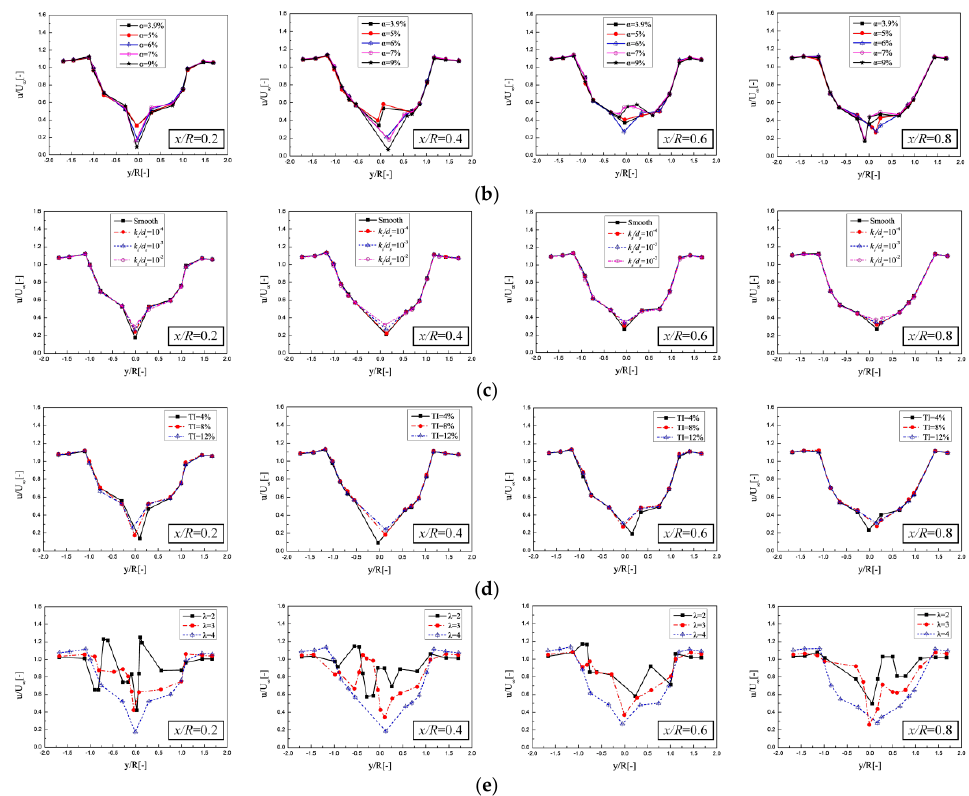
Figure 13. ( a ) The four measured positions of wind velocity inside the wind turbine; ( b ) fluctuation of wind velocity in downstream region of x / R = 0.2, 0.4, 0.6, 0.8 at different α ; ( c ) fluctuation of wind velocity in downstream region of x / R = 0.2, 0.4, 0.6, 0.8 at different k s / d s ; ( d ) fluctuation of wind velocity in downstream region of x / R = 0.2, 0.4, 0.6, 0.8 at different turbulence intensity (TI); and, ( e ) fluctuation of wind velocity in downstream region of x / R = 0.2, 0.4, 0.6, 0.8 at different tip speed ratios (TSRs).